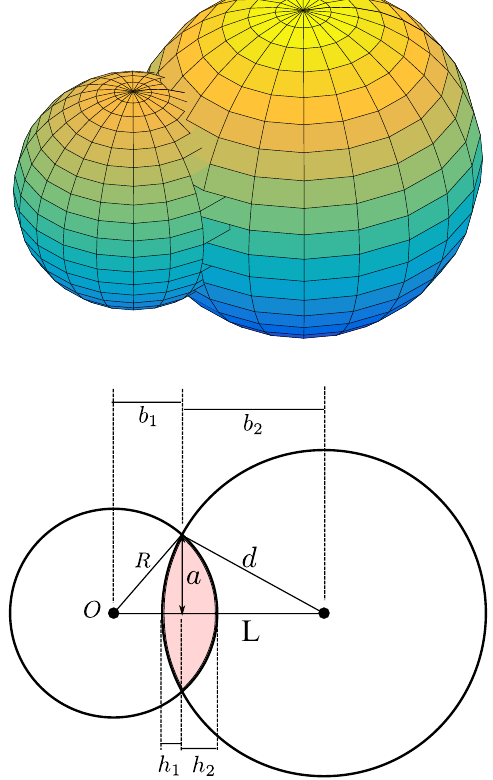
Figure 2. The geometry underlying the probability distribution of d n